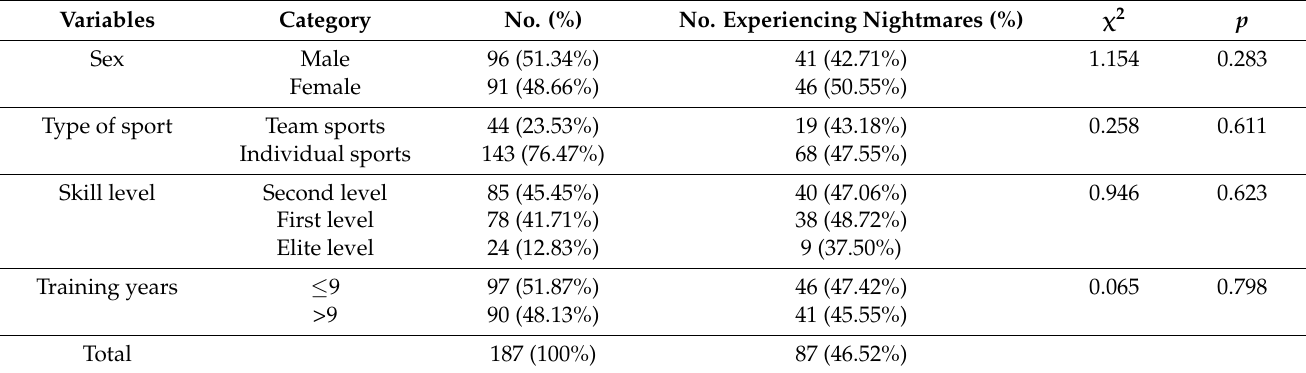
Table 1. Comparison of nightmare experiences among athletes with different sex and sports-related characteristics (n =